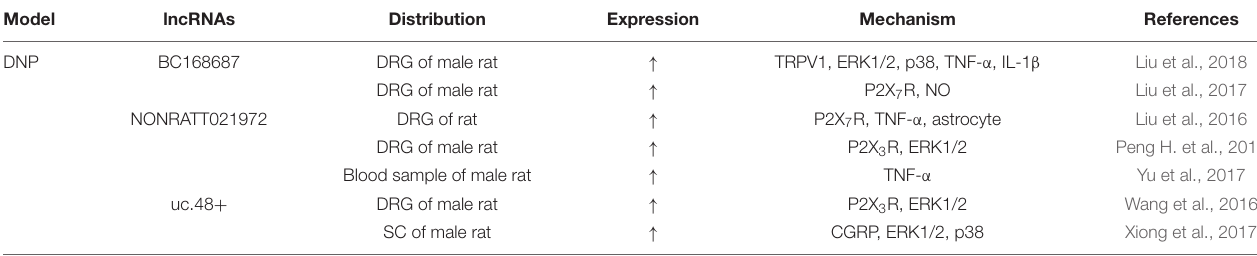
TABLE 2 | lncRNAs and diabetic neuropathic pain.